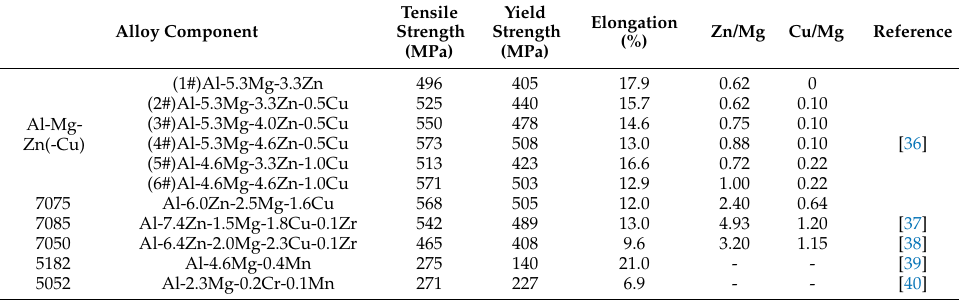
Table 1. Mechanical properties of the different alloy states at room temperature